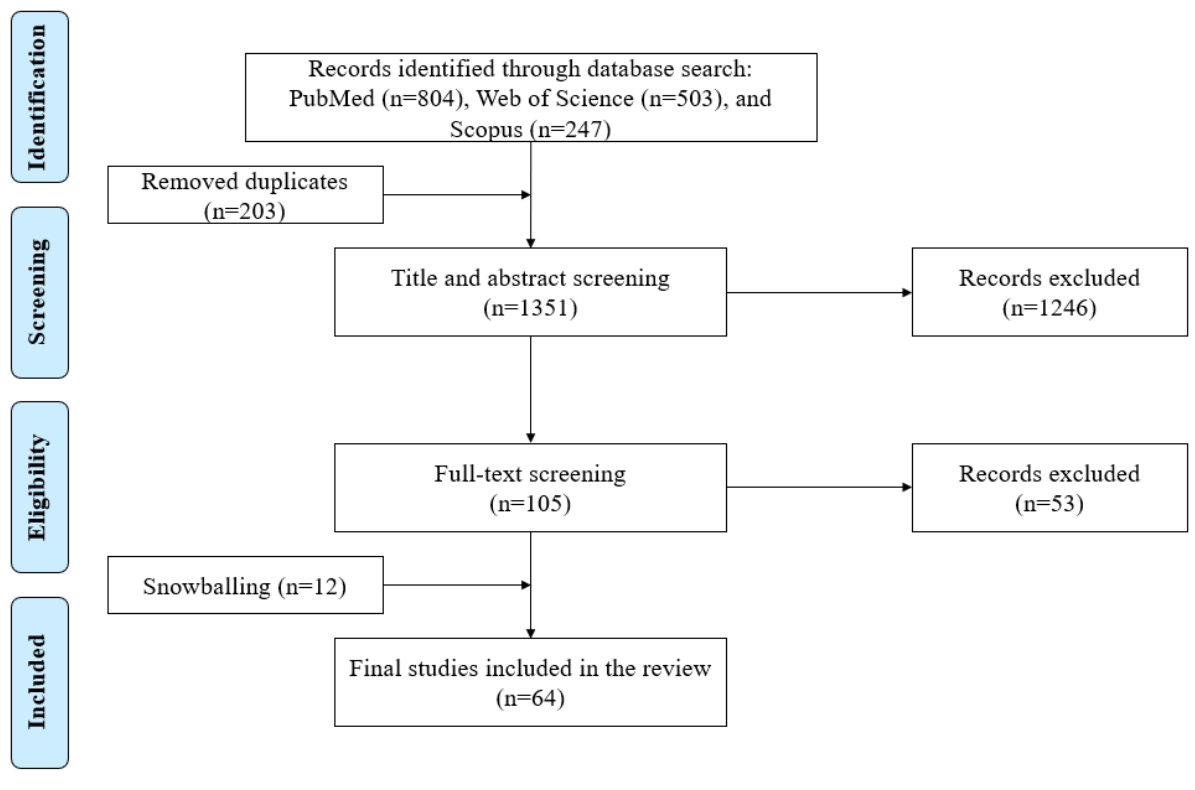
Figure 1. PRISMA (Preferred Reporting Items for Systematic Reviews and Meta-Analyses) diagram for study